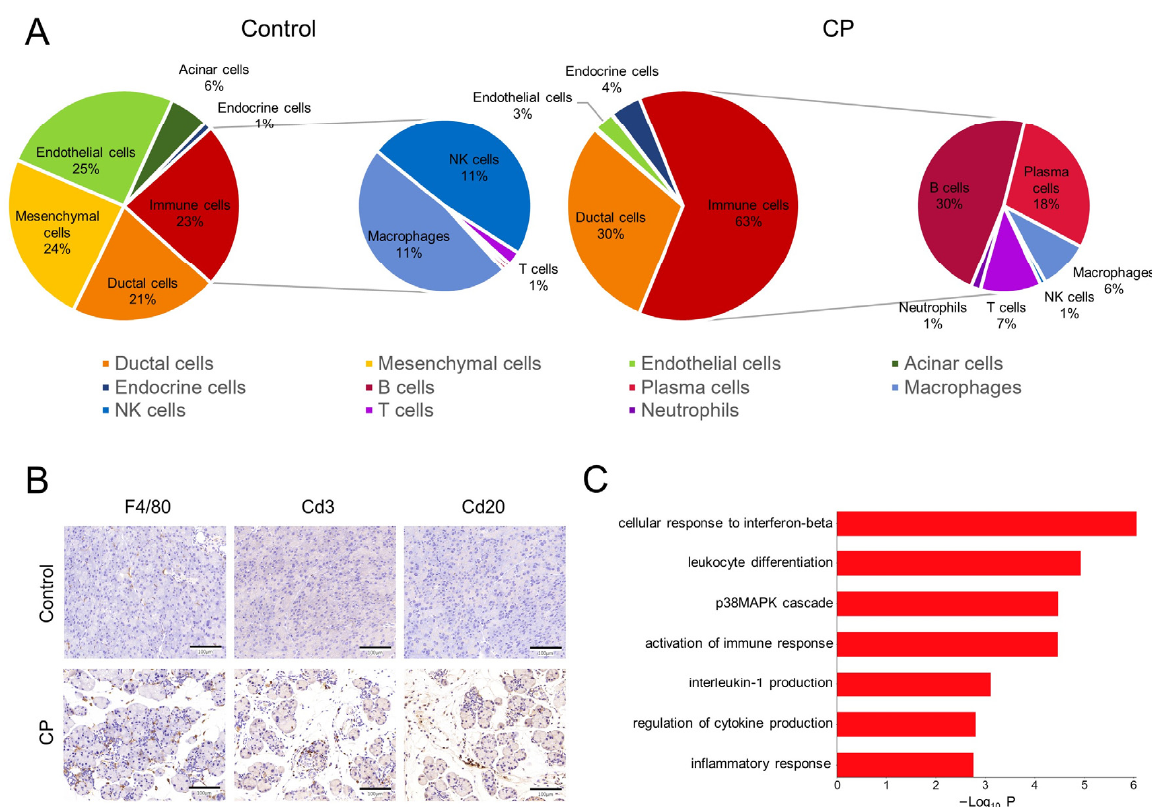
Figure 4. Alterations to immune cells in CP mice. ( A ) Pie charts showing the percentage of classified different cell types. The CP group had a higher proportion of immune cells and distinct immune cell profiles compared to the control group. ( B ) The immunohistochemical analysis showed the infiltration of F4/80 macrophages, Cd3 T cells, and Cd20 B cells in pancreatic sections from CP mice. Scale bar = 100 μ m. ( C ) Significant GO terms enriched for upregulated genes of macrophages from the CP group.